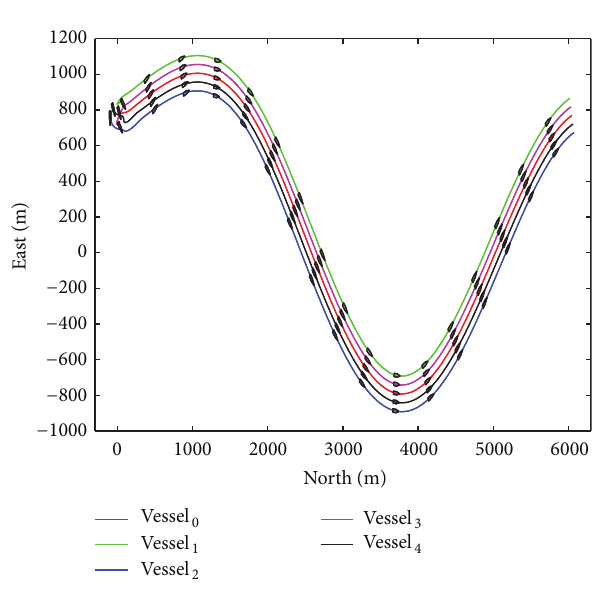
Figure 2: The dynamic trajectory of each